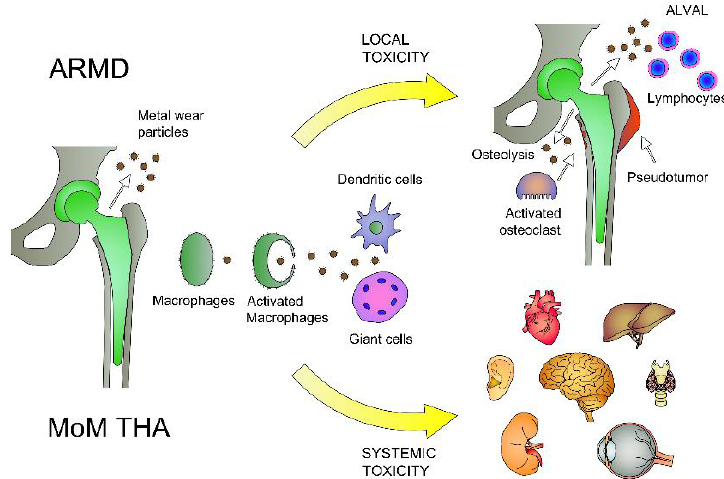
Figure 1. Local and systemic toxicity of metal-on-metal (MoM) metal debris. Metal debris, released from the implant by corrosion or wear, causes local periprosthetic alterations called adverse reaction to metal debris (ARMD), mediated by di ff erent types of cells including macrophages, osteoclasts, giant cells, dendritic cells and lymphocytes. Tissue alterations can cause osteolysis (induced by osteoclasts and macrophages) at the bone-level, or pseudotumor formation and aseptic lymphocyte–dominated vasculitis-associated lesions (ALVAL) at the soft tissue-level. Periarticular metal debris can be disseminated to di ff erent organs through circulatory and lymphatic systems causing systemic toxicity.